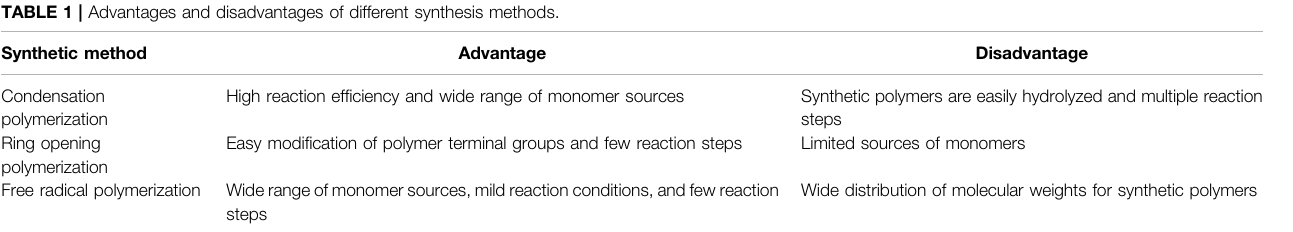
TABLE 1 | Advantages and disadvantages of different synthesis